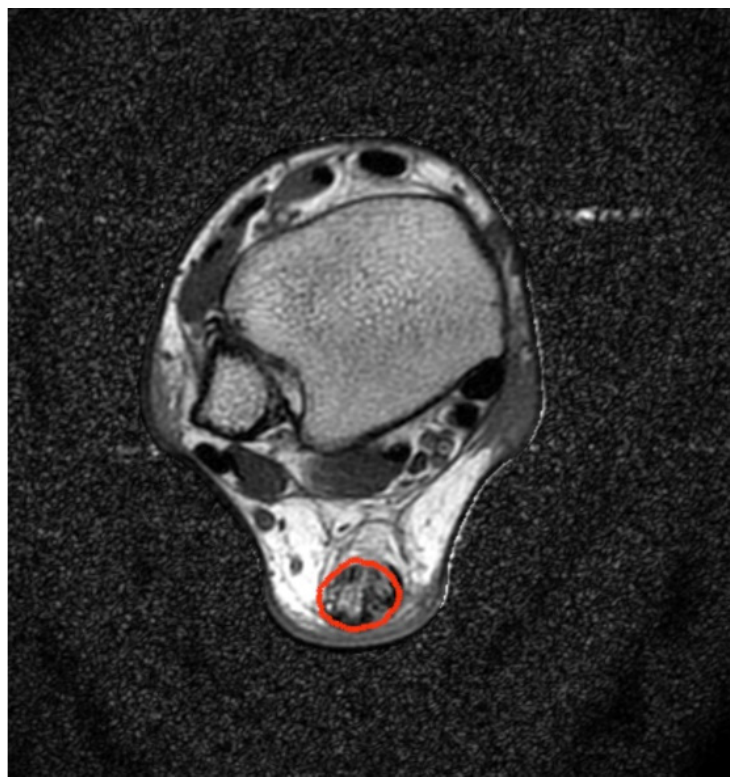
Figure 4. Intensity signal obtained with TE = 18 ms. The high level of noise in the surrounding air was noticeable. Segmentation of the AT region (outlined in red) was provided automatically. Biexponential T2 map reconstructions were performed based on segmented AT regions.